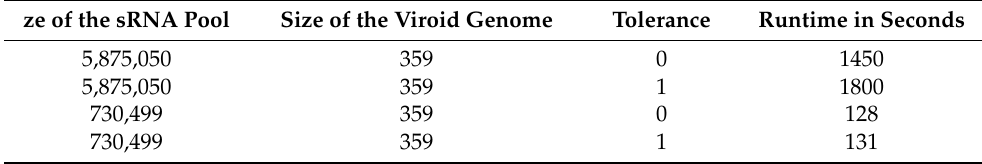
Table 6. The runtime of the sRNA profiler on a single core of 3.2